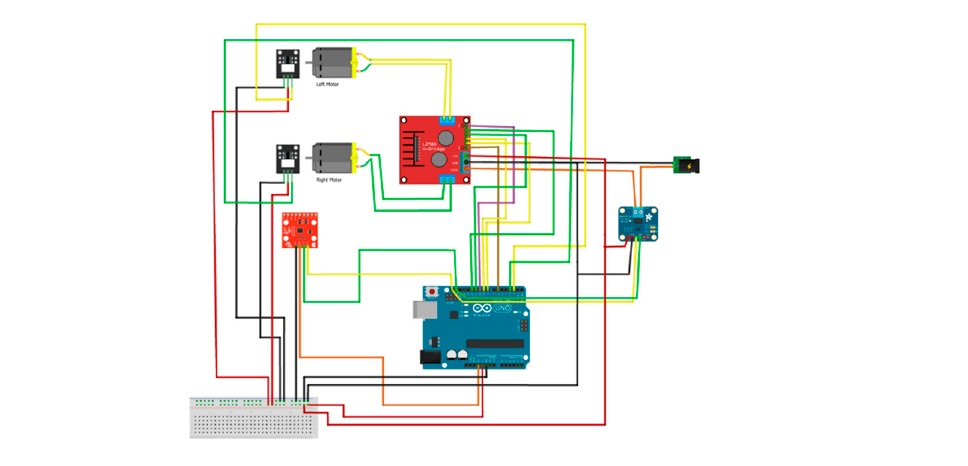
Figure 7. GPS module performance inspection and adjustments, using the u-blox environment for u-blox chip-based devices, via a USB connection.